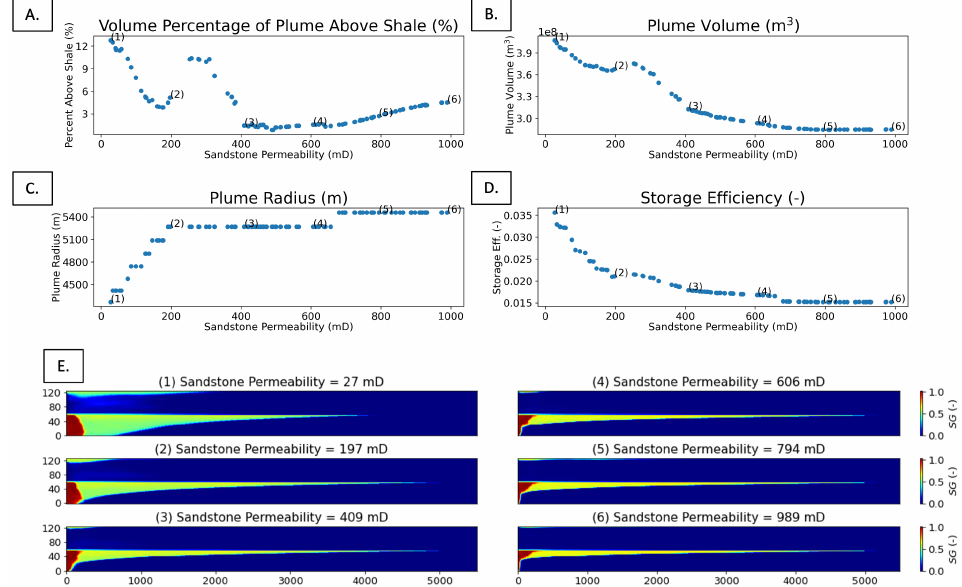
Figure 7. The impact of sandstone permeability on plume migration. ( A – D ) illustrate the relationship between four plume variables and the sandstone permeability; each is fit by a low-order polynomial or logarithmic function. ( E ) shows the gas saturation map of six modeled cases (labeled in ( A – D